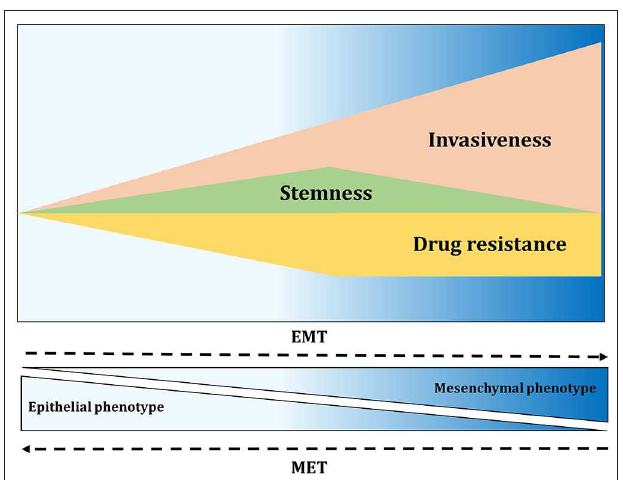
FIGURE 5 | EMT contributes to invasiveness, stemness, and drug resistance. Activation of EMT results in migration and fast tissue invasion. Furthermore, EMT activation affects tumor-initiating properties of cancer cells, with the greatest properties found at the intermediate level of EMT. Drug resistance of cancer cells also seems to be highest in cells with intermediate EMT phenotype.